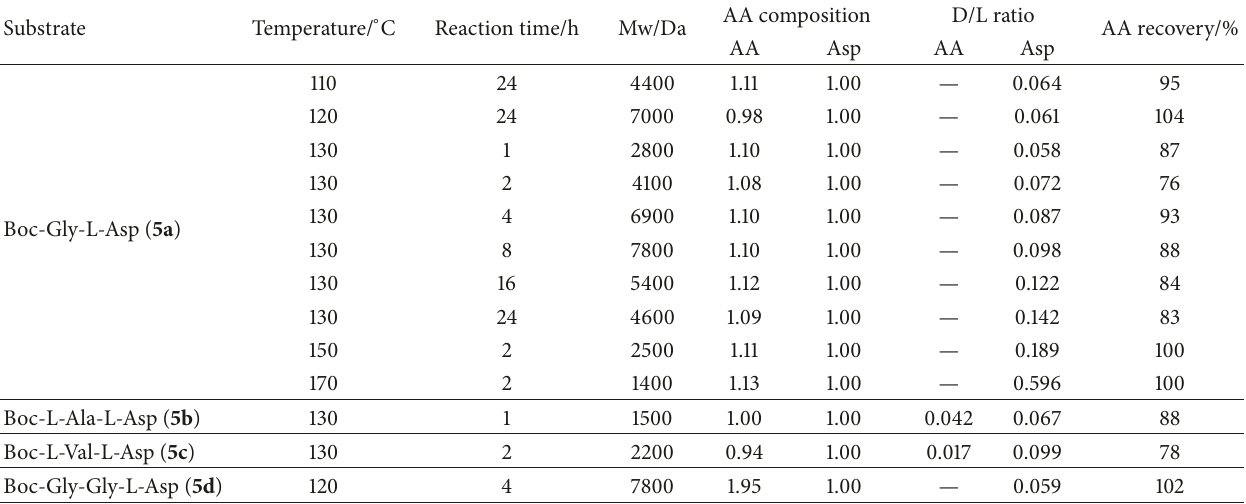
Table 3: Amino acid composition and D/L ratio of hydrolysates of the higher molecular weight